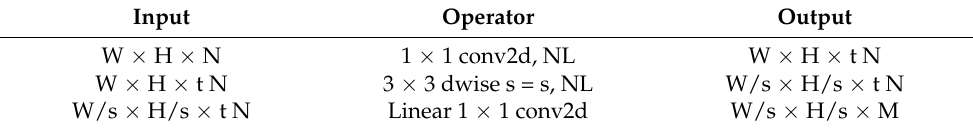
Figure 6. The procedure of PD pattern recognition by MCNN. Table 1. Core module construction of